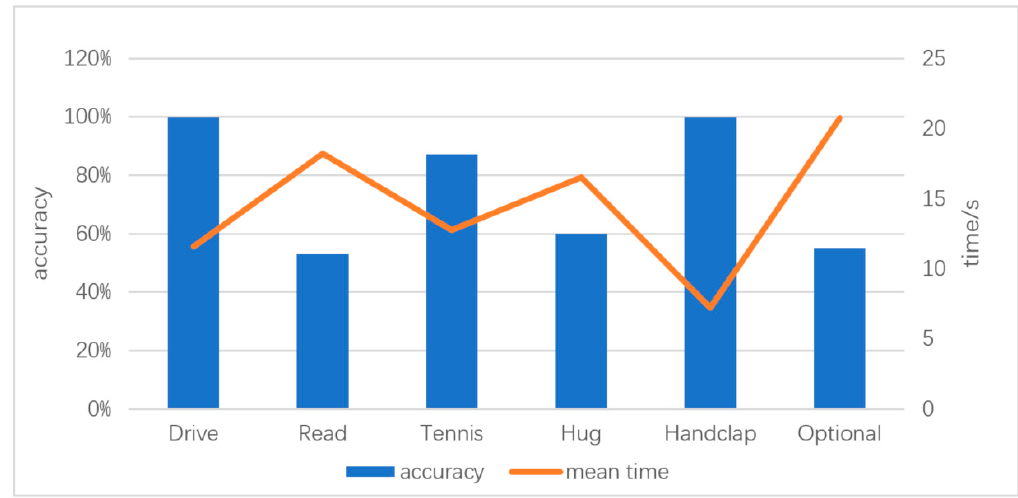
Figure 7. Recognition accuracy and mean time of actions.